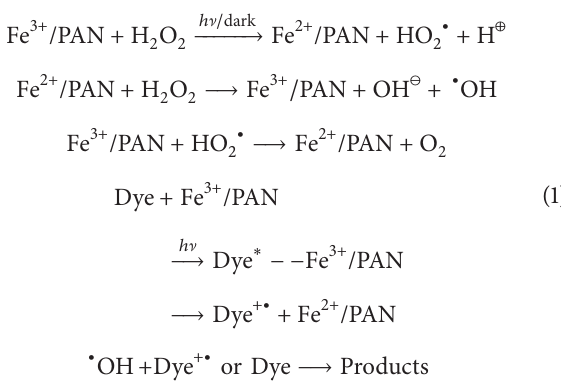
𝐷 % values of RR 195 in different systems: (a) RR 195 and H 2 O 2 under visible irradiation, (b) RR 195, Fe-AO- PAN and H 2 O 2 under dark, (c) RR 195, Fe-AO-PAN, and H 2 O 2 under visible irradiation, (d) RR 195, Fe-AO-n-PAN, and H 2 O 2 under dark, and (e) RR 195, Fe-AO-n-PAN, and H 2 O 2 under visible irradiation. The experiments were carried out under conditions: = 3.42 mmolg −1 ), [H 2 O 2 ] = 3.0mmol L −1 , pH = 6, Fe-AO-PAN ( 𝑄 Fe = 3.38 mmolg −1 ) = 0.20 or Fe-AO-n-PAN ( 𝑄 Fe